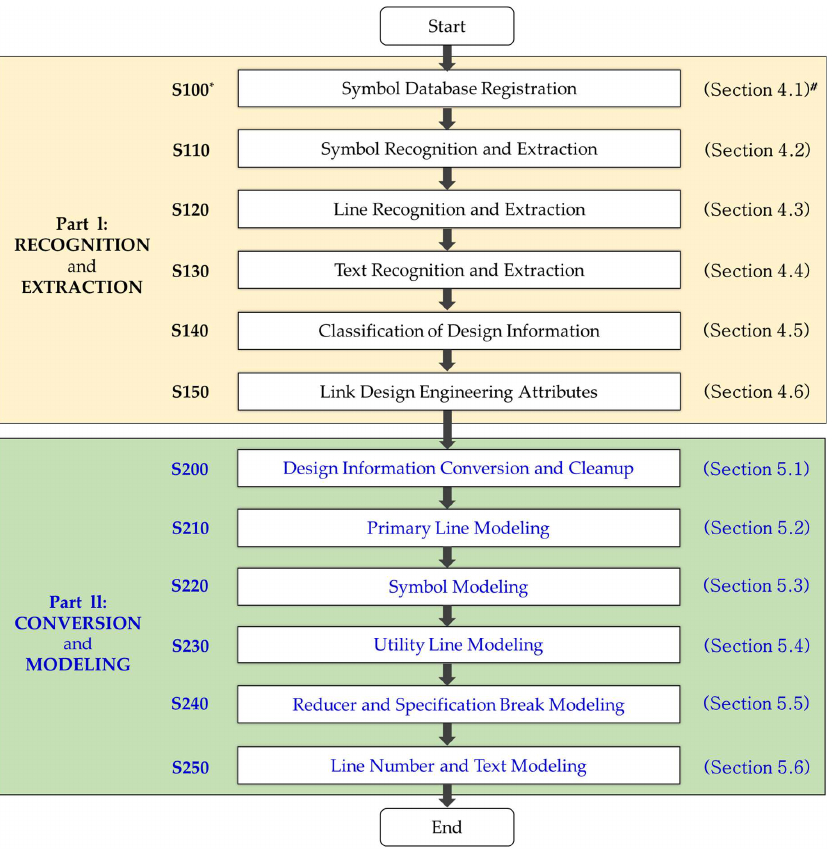
Figure 1. Overall process of intelligent piping and instrumentation diagram (P&ID). (Note: * indicates process step number, whereas # shows the related section number in the paper). The method of automatic recognition and classification of design information in imaged P&ID